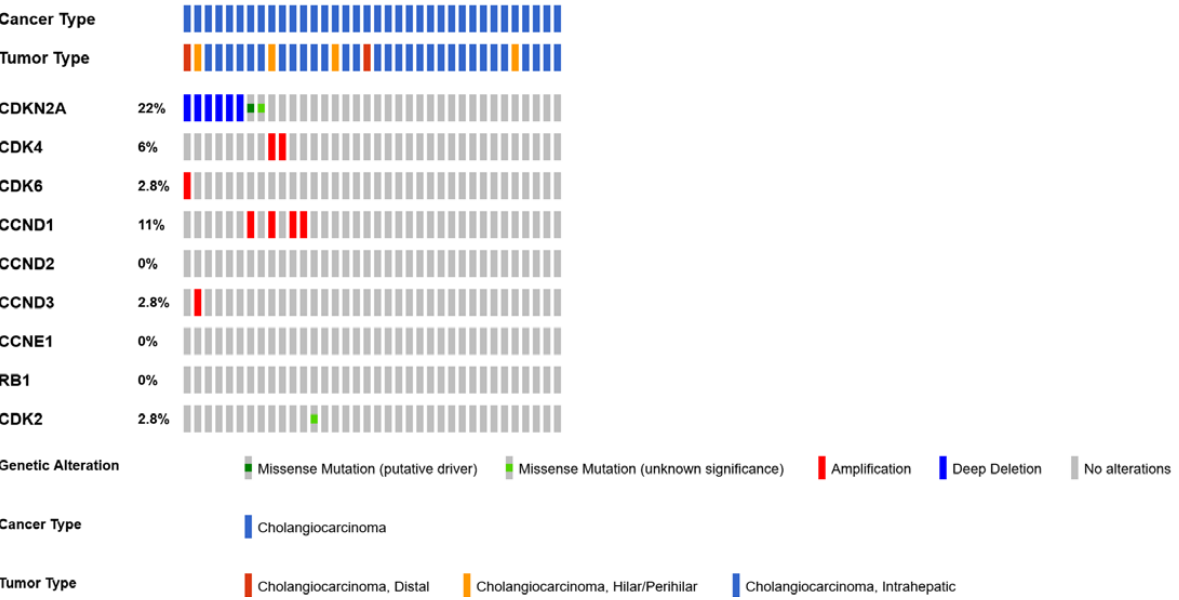
Figure 4. OncoPrint of the RB pathway alterations in CCA, showing mutations and copy number alterations (The Cancer Genome Atlas Program (TCGA)).